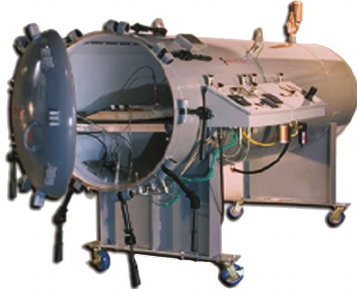
Figure 3: Heatcon Composite System—Repair Clave Model HCS3100